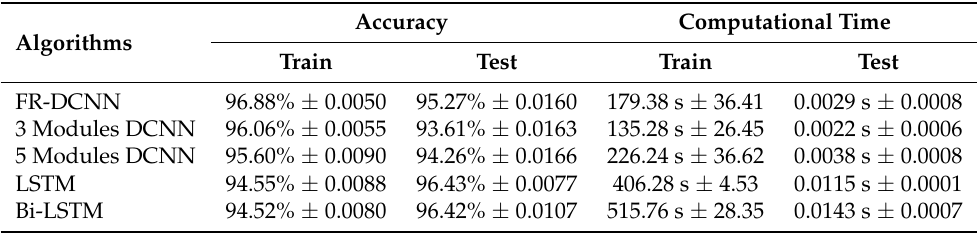
Table 2. The comparison performance on the whole training dataset (90%) among FR-DCNN, DCNNs, LSTM, and